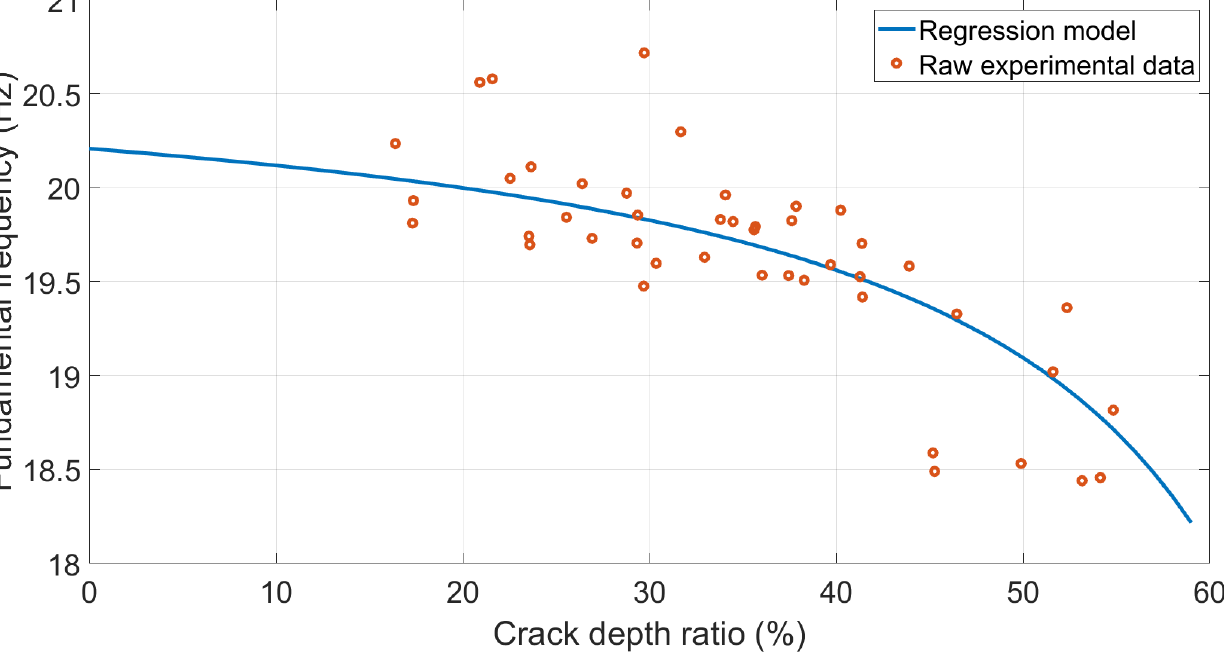
Figure 11. Modelled fundamental frequency and experimental data comparison.